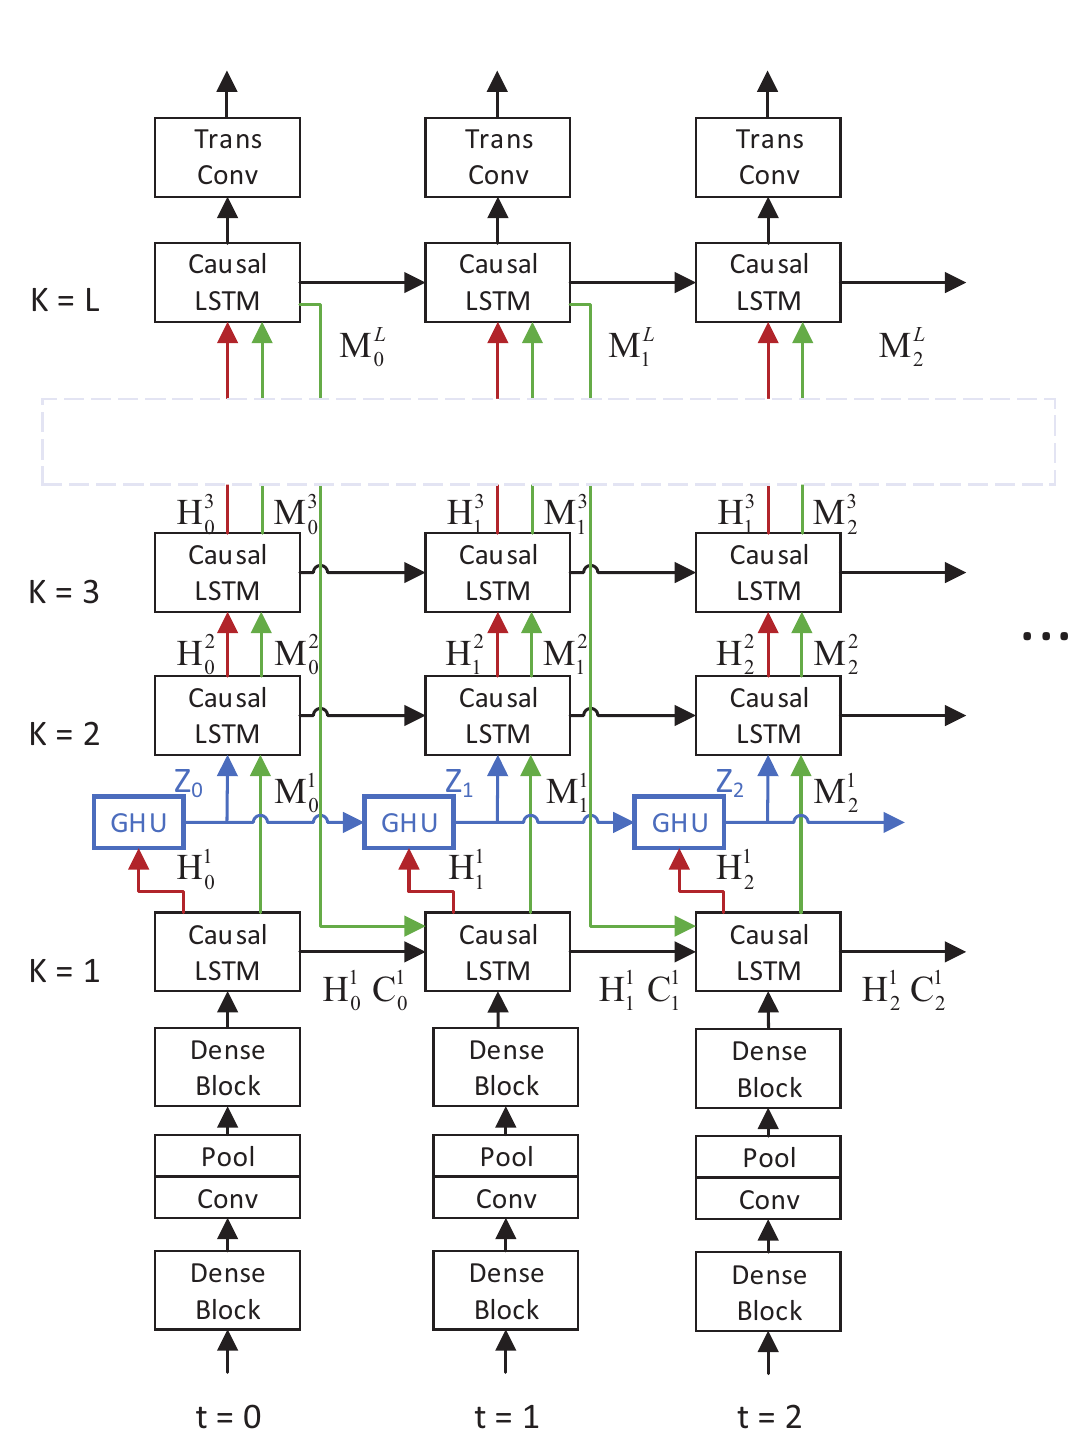
Figure 1. The structure of the DC-LSTM model. Figure 2 shows the prediction mechanism of the whole system. In the training phase, for the input, probability p is the true value, and probability 1- p is the last prediction. In the initial stage, the prediction ability of the model is weak, and the value of p is 1. With the increase of training iterations, the value of p decreases gradually. In the verification phase, p is fixed to 0. The specific structure of each module is as